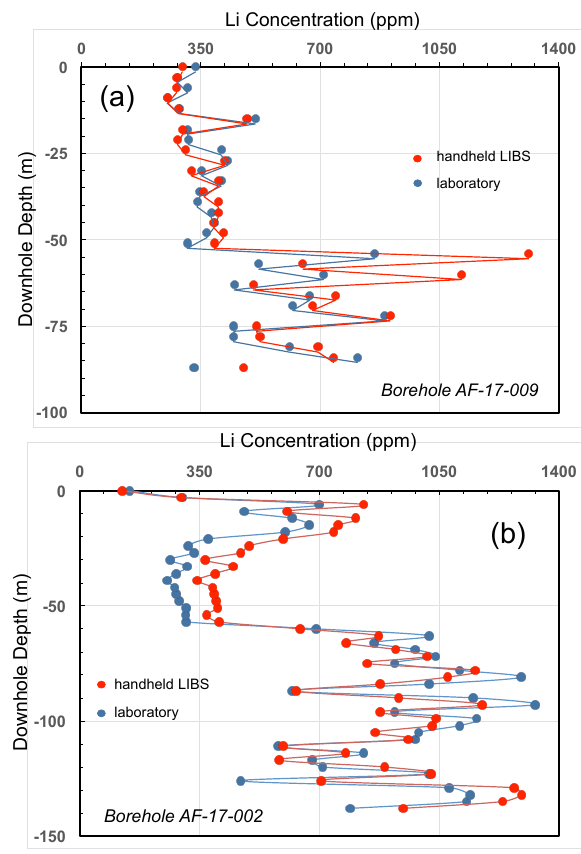
Figure 14. Comparison of Li concentrations for the Agua Fria prospect drill core by handheld LIBS and laboratory analysis for ( a ) drill hole AF-17-004, where the entire hole represents the calibrated clay matrix showing concordance between the laboratory and LIBS analyses, and ( b ) drill hole 17-002, where the upper 60 m of the hole intersects a non-calibrated basalt matrix; although the handheld LIBS still shows a similar overall pattern of downhole Li variation, a significant di ff erence between the laboratory and LIBS analyses is evident. Analytical performance improves once the calibrated clay matrix is encountered at approximately 60 m